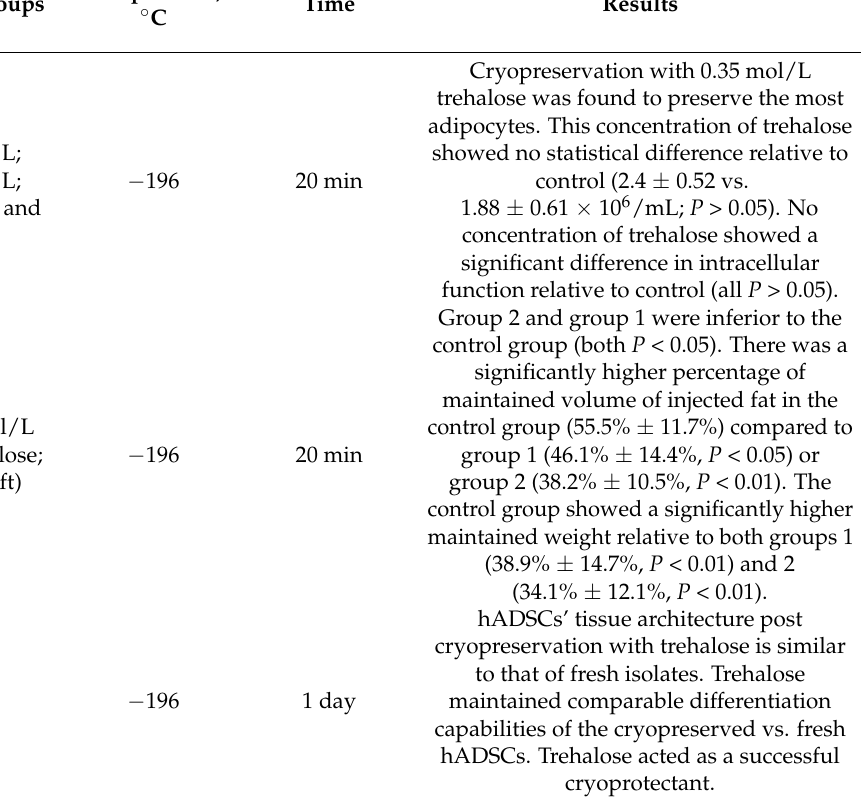
Table 3. Cryopreservation using trehalose vs. fresh fat control or simple cryopreservation.